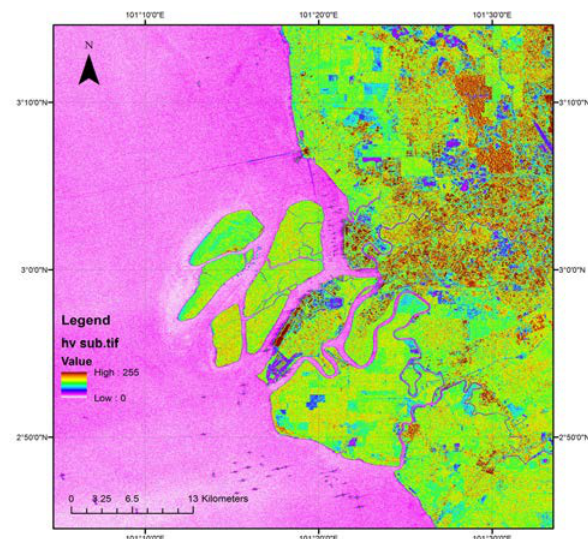
Figure 2. Image map of Kuala Lumpur estuary extracted from PALSAR HV polarization channel.